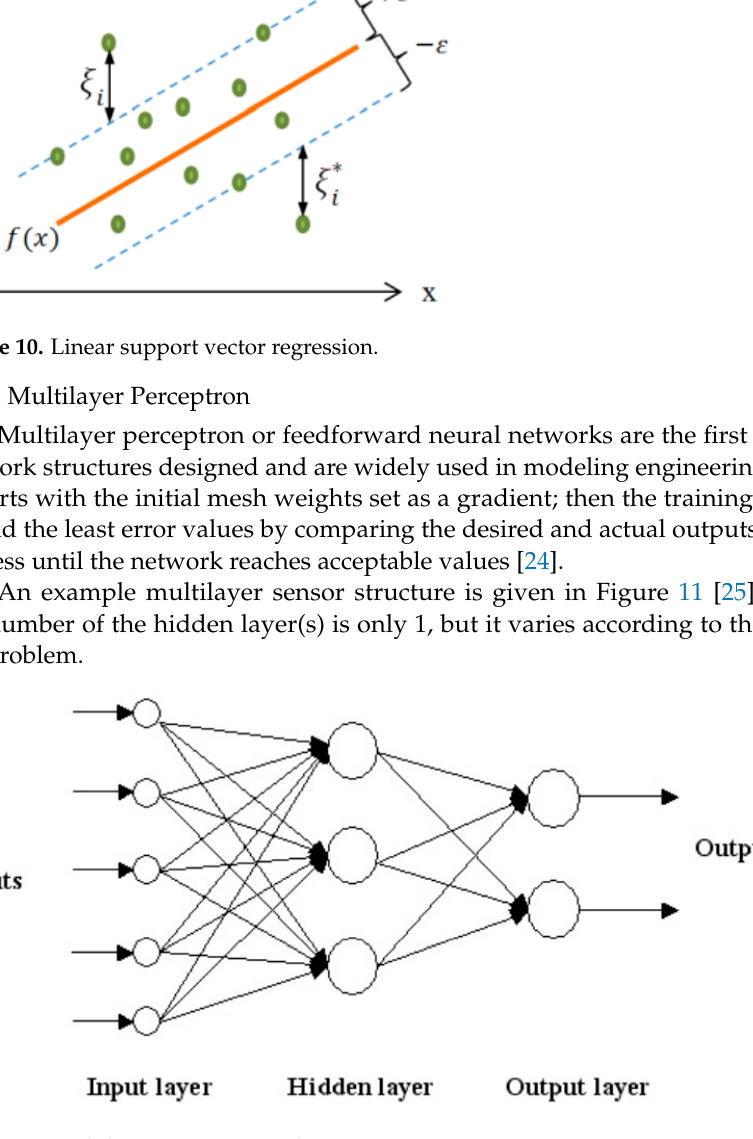
9 of 19 Figure 9. XGBoost schematic representation. In this method, f t ’ s are collected to minimize the following expression, with the i ‐ numbered estimation component ŷ i ( t ) in the t iteration [20]. ℒ (cid:4666)(cid:3047)(cid:4667) (cid:3404) ∑ 𝑙 (cid:4672)𝑦 (cid:3036) , ŷ (cid:3036)(cid:4666)(cid:3047)(cid:2879)(cid:2869)(cid:4667) (cid:3397) 𝑓 (cid:3047) (cid:4666)𝑥 (cid:3036) (cid:4667)(cid:4673) (cid:3397) Ω(cid:4666)𝑓 (cid:3047) (cid:4667) (cid:3041) (cid:3036)(cid:2880)(cid:2869) (5) 2.2.5. Support Vector Regression The support vector machine is a machine learning method that can be used for non ‐ linear regression and pattern recognition and is based on statistical learning theory and structural risk minimization theory. This method’s nonlinear regression application is called support vector regression [21]. The method was first proposed by Cortes and Vap ‐ nik and used by Vapnik in 1995 as a new type of universal learning machine that imple ‐ ments the strategy of keeping the empirical risk constant by minimizing the confidence